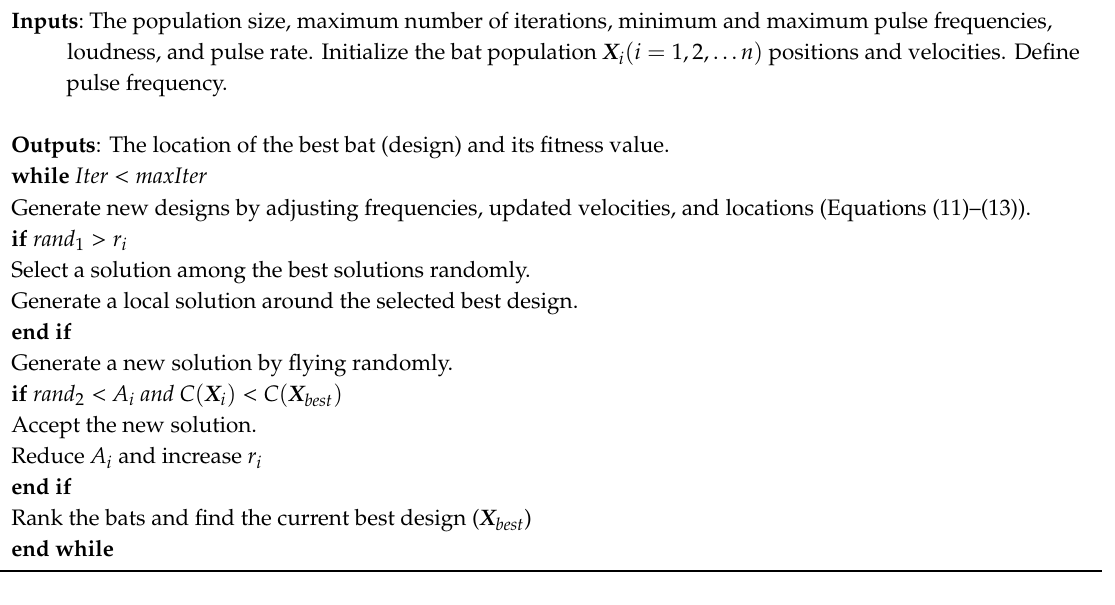
Algorithm 1 . Pseudocode of BA